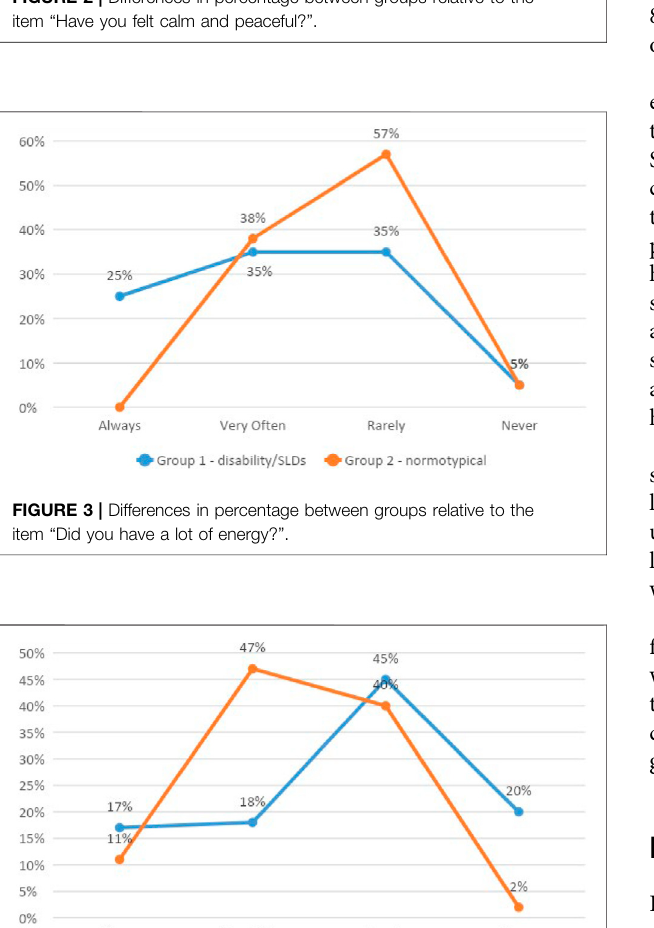
Frontiers in Education |